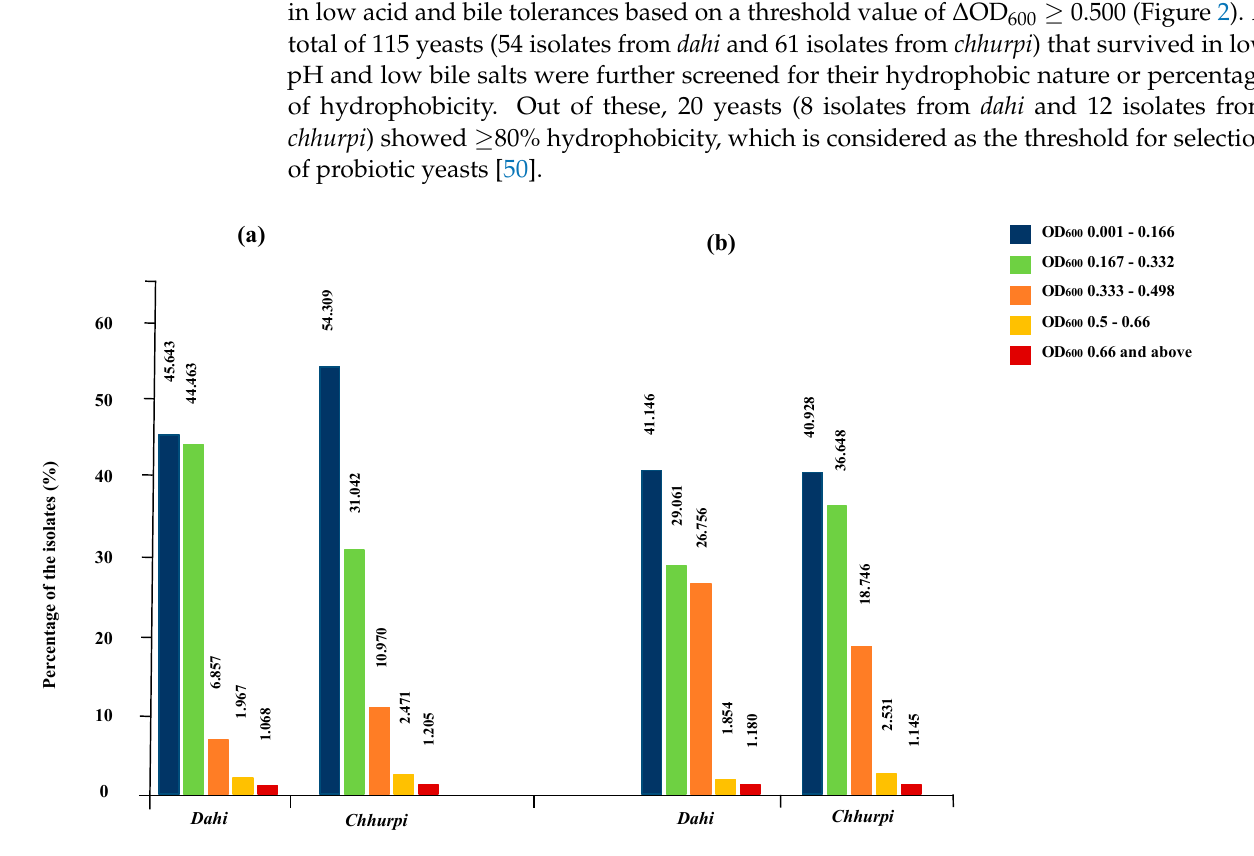
Table 3. Phenotypic characterization of probiotics yeasts isolated from dahi and chhurpi of Sikkim.